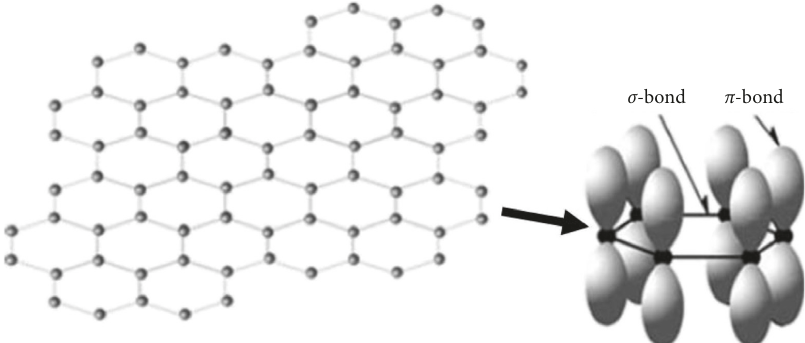
Figure 3: The graphene structure (taken from